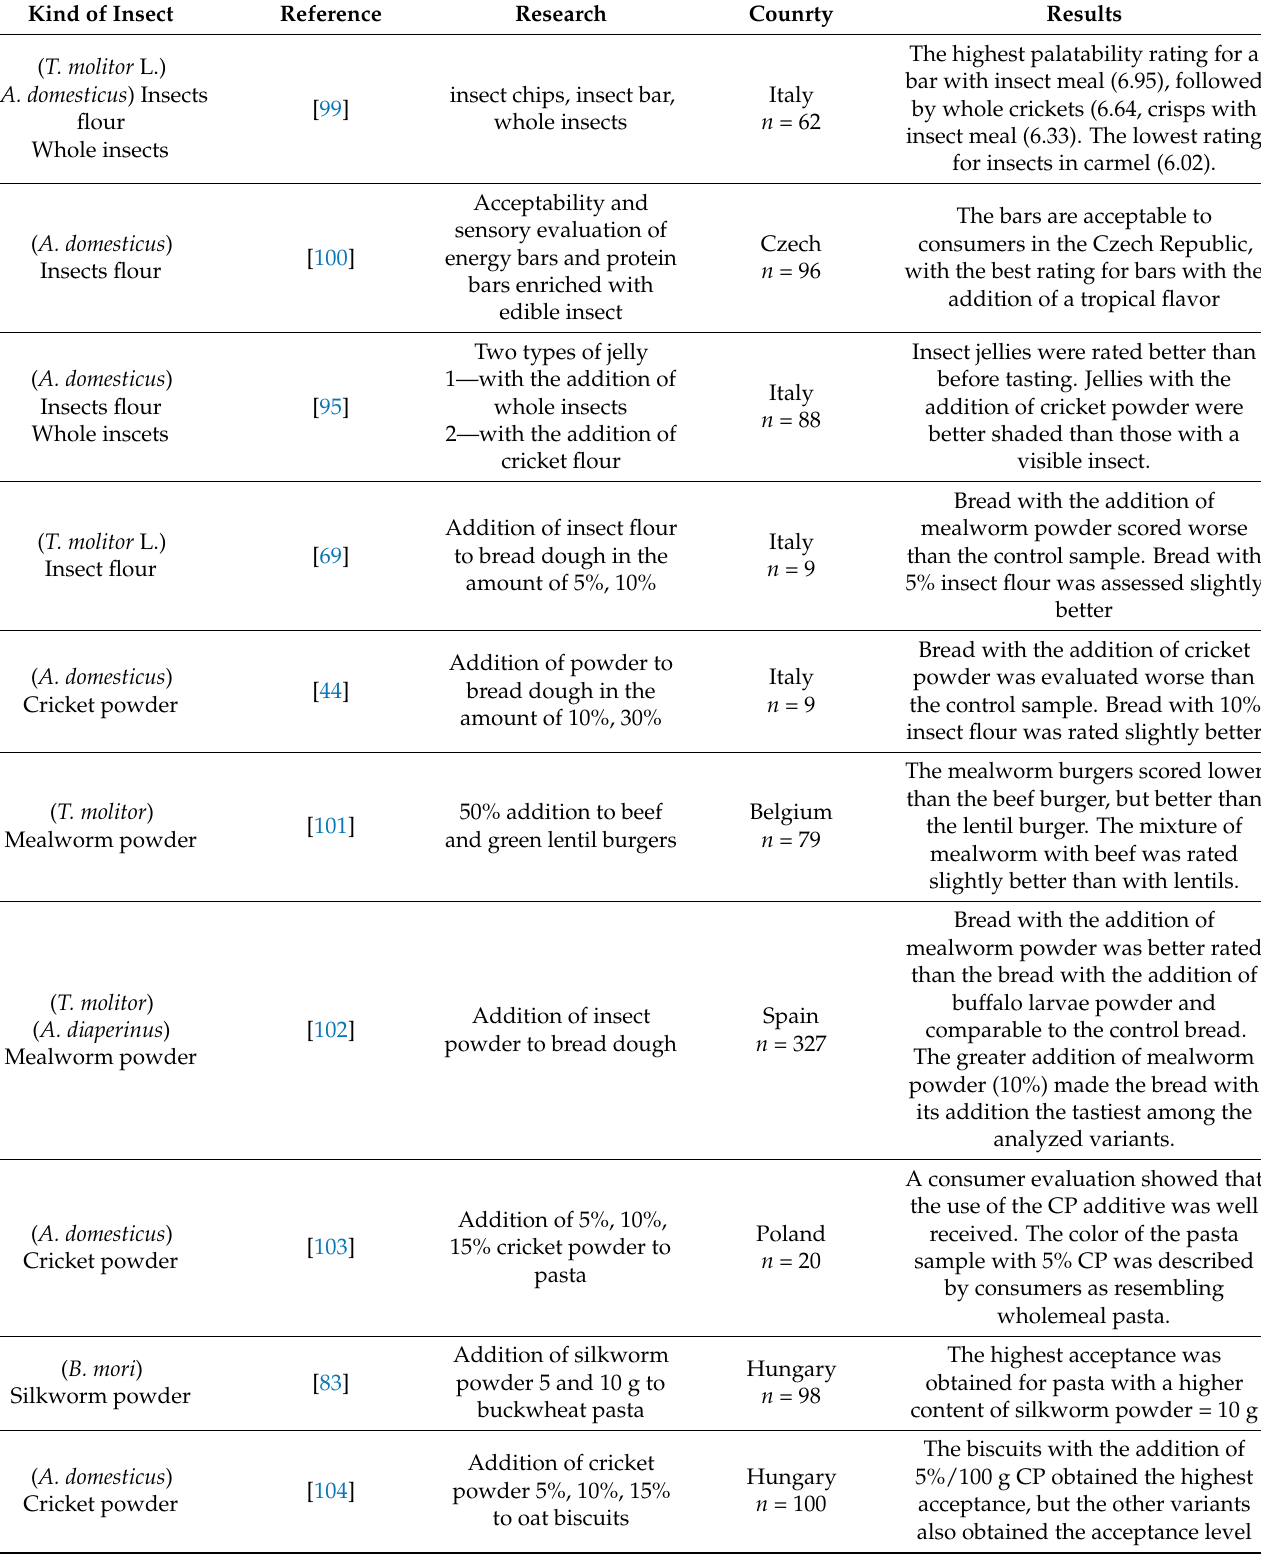
Table 1. Summary of studies on implementation of insects as functional additives to food in